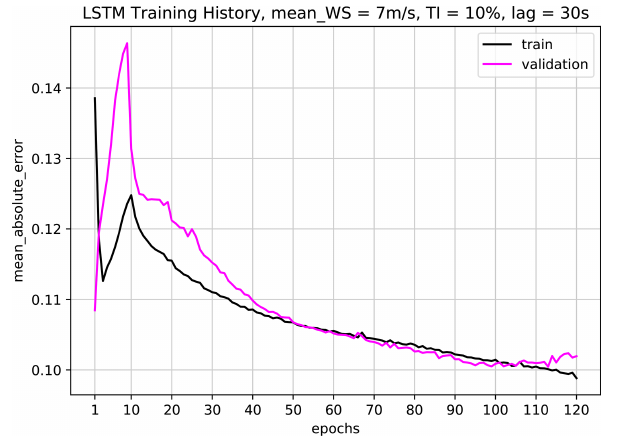
Figure 5. Training history of the first LSTM network with mean wind speed = 7ms − 1 , mean TI = 10% and time lag = 29s. The network architecture is presented in Table 2, where batch size = 60 with Adam optimization algorithm and mean absolute error (MAE) loss function implemented. The training is stopped at epoch = 100, after which the network training starts to show symptoms of overfit.